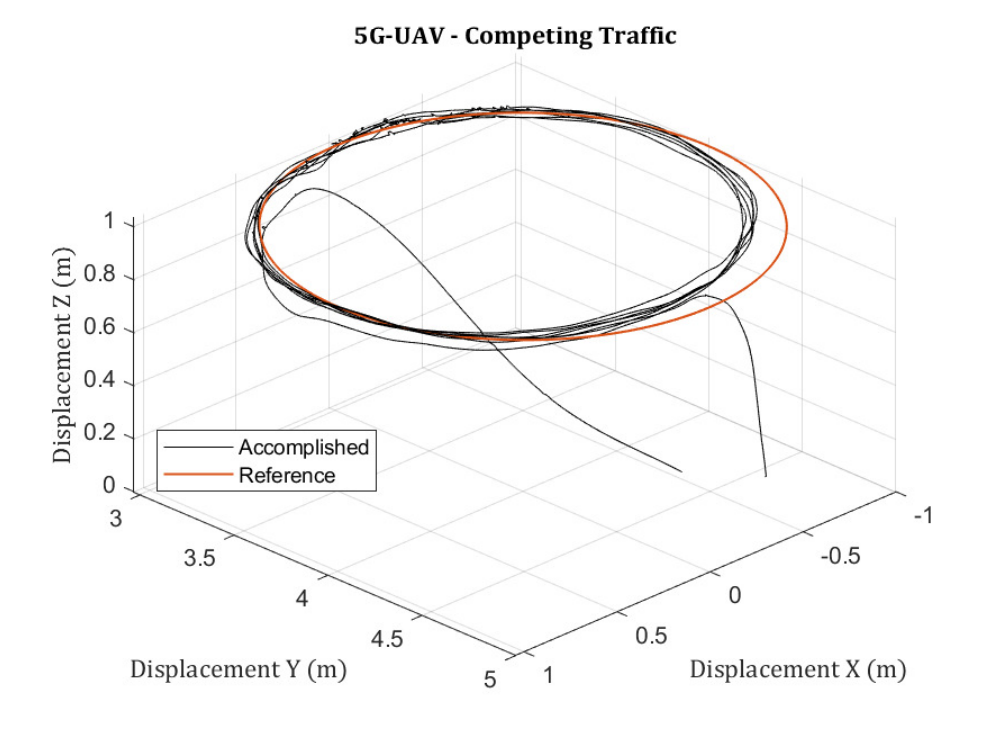
Figure 11. A 5G-UAV’s trajectory when offloading sensors from competing agents or competing